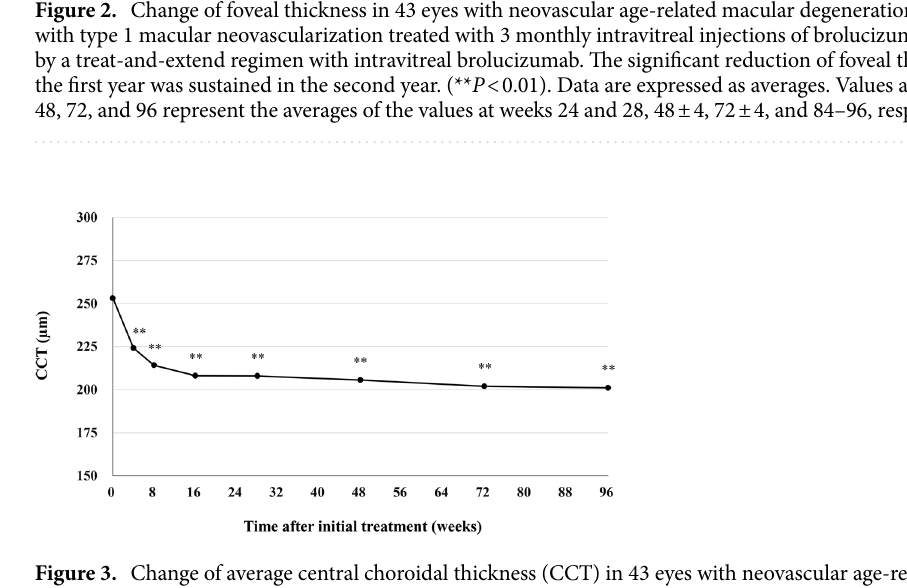
Figure 3. Change of average central choroidal thickness (CCT) in 43 eyes with neovascular age-related macular degeneration associated with type 1 macular neovascularization treated with 3 monthly intravitreal injections of brolucizumab followed by a treat-and-extend regimen with intravitreal brolucizumab. The significant reduction of CCT in the first year was also maintained in the second year. (** P < 0.01). Data are expressed as averages. Values at weeks 28, 48, 72, and 96 represent the averages of the values at weeks 24 and 28, 48 ± 4, 72 ± 4, and 84–96,